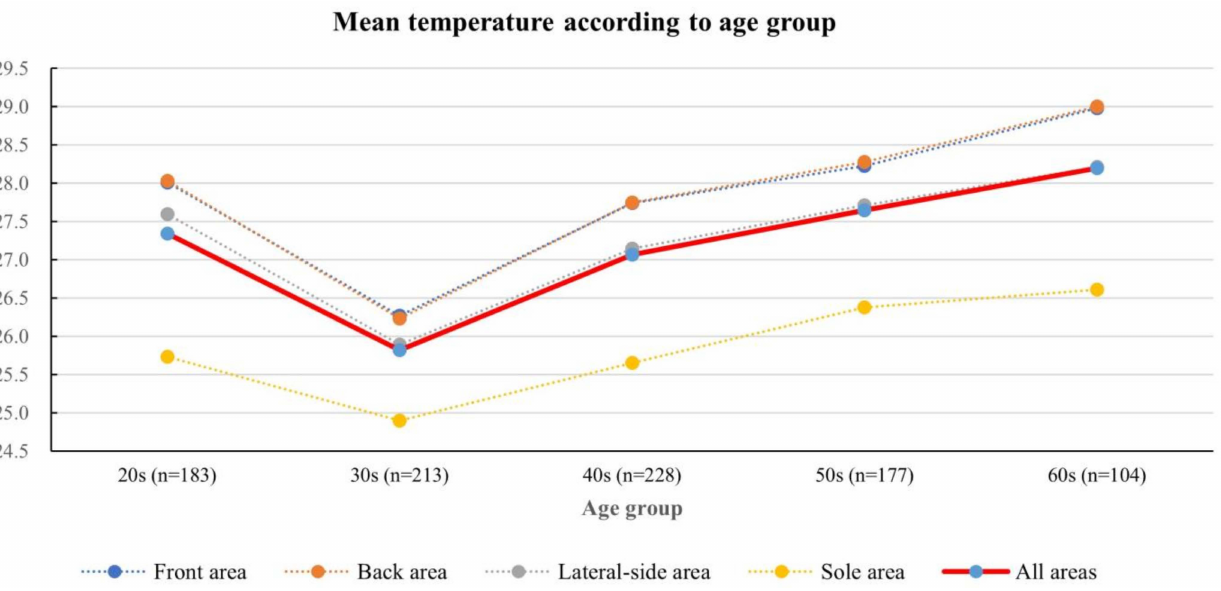
Figure 7. Trend of temperature according to age group in each